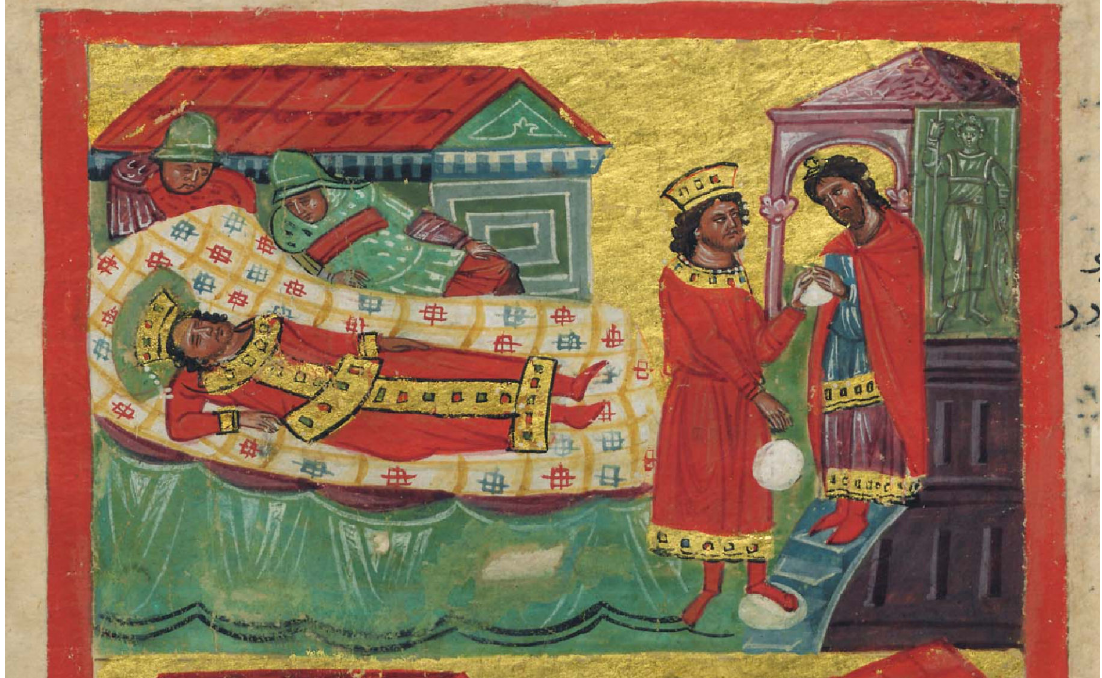
Figure 16. Venice. Istituto Ellenico di Studi Bizantini e Postbizantini cod. 5, fol. 53r (detail). Alexander’s dream/Alexander visits the temple of Zeus. Photo: ©Istituto Ellenico di Studi Bizantini e Postbizantini, Venice, all rights